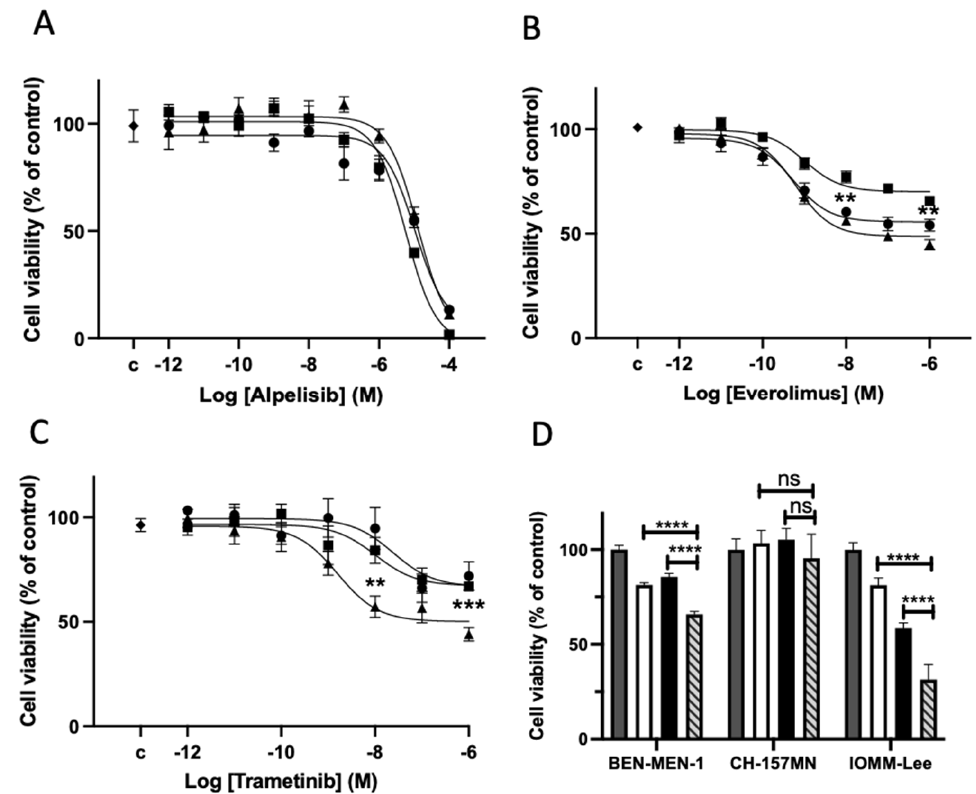
Figure 2. Alpelisib, trametinib and everolimus alone ( A – C ) or in combined treatment ( D ) on the cell viability of the 3 meningioma cell lines: Ben-Men1 (black round), CH-157MN (black square) and IOMM-Lee (black triangle). ( A – C ): Dose-effect curve under treatment for 3 days. Each experiment was done 3 times in triplicate. Results are expressed as mean ± SEM percentage of cell viability in comparison to DMSO (dimethylsulfoxide) treated control cells (“c”). ( B ): ** p < 0.01 between the everolimus inhibitory effect on CH-157MN vs. that on Ben-Men1 or on IOMM-Lee at 10 − 8 M or 10 − 6 M. ( C ): *** p < 0.001 between the trametinib inhibitory effect on IOMM-Lee vs. that on Ben-Men1 or on CH-157MN at 10 − 8 M. ** p < 0.01: the same at 10 − 6 M; ( D ): Combined treatment of alpelisib 10 − 6 M with trametinib 10 − 8 M (hatched bar) in comparison with alpelisib 10 − 6 M alone (white bar) and with trametinib 10 − 8 M alone (black bar) at 3 days. Results are expressed as mean ± SEM percentage of 3 experiments in triplicate, of cell viability relative to DMSO-treated control cells (grey bar). ns: non-significant. **** p < 0.0001